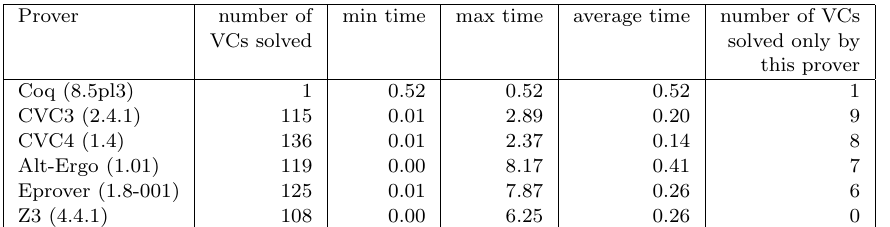
Fig. 6. Summary of proof